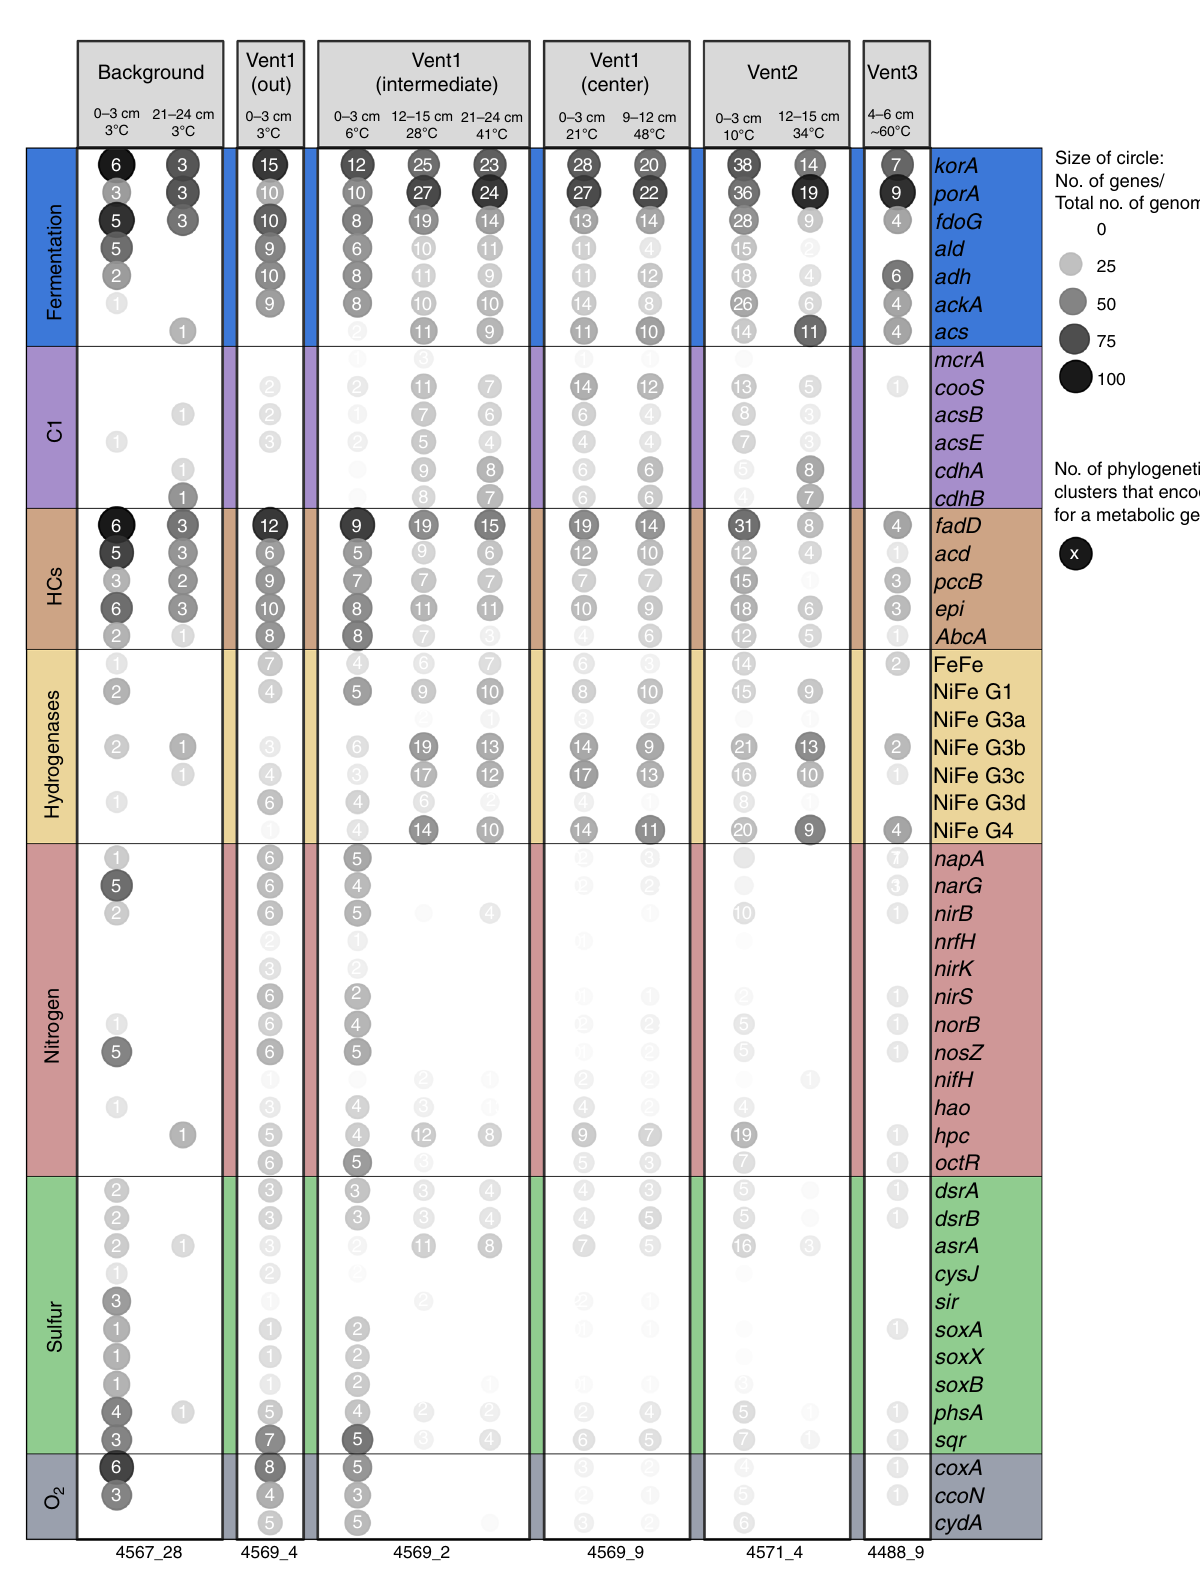
Fig. 6 Metabolic pro fi le across different GB sediment sites, depth pro fi les and temperature regimes. Shown is the number of core metabolic genes relative to the total number of genomes (in %) per site, depth and temperature regime. Temperatures are averages for the 2 or 3 cm thick sediment layers from which DNA was isolated. Background samples: Cold GB samples without hydrothermal activity. Vent1 – 3: Hydrothermal sediment sampling locations, see also Fig. 1. ID at the bottom: number codes designating every Alvin dive and sediment core (see also Supplementary Data 1 for further explanation). A complete list of metabolic genes can be found in Supplementary Data 10. Number in circles: Number of phylogenetic clusters that encode for individual core metabolic genes at each